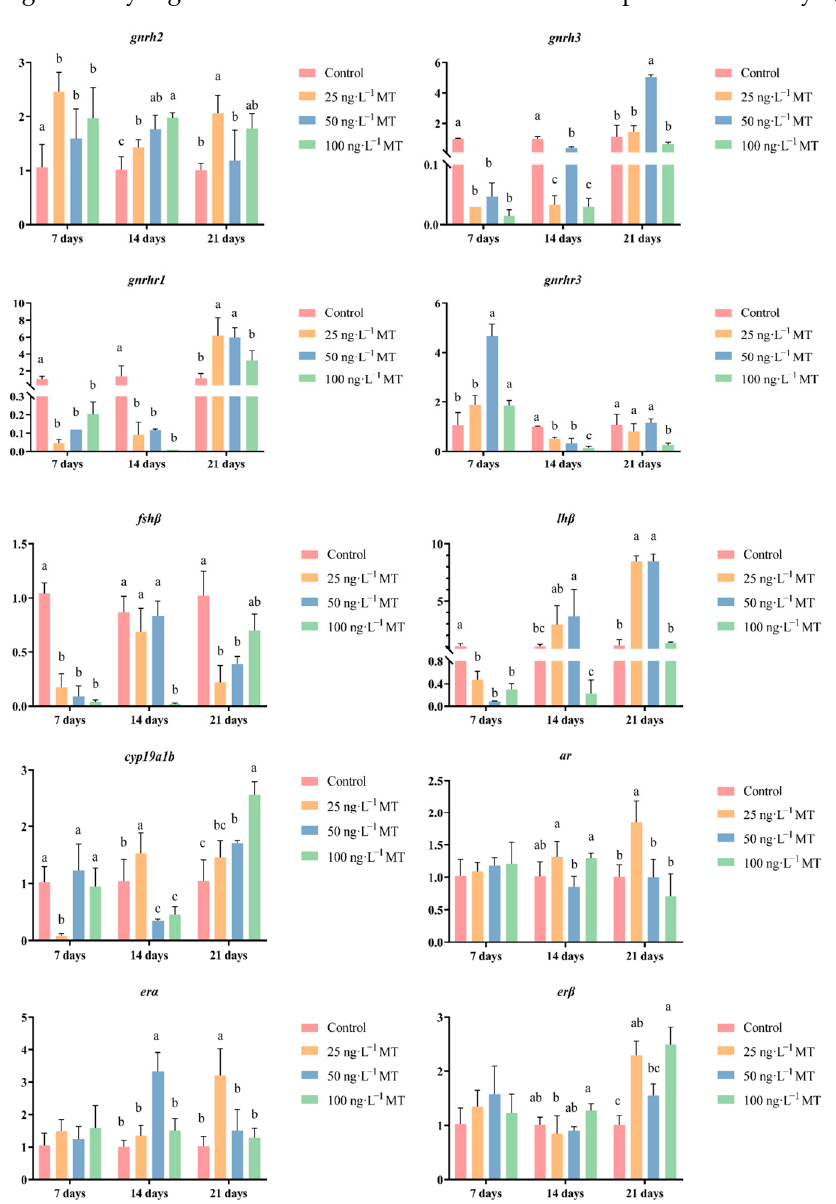
Figure 3. Effect of MT on gnrh2 , gnrh3 , gnrhr1 , gnrhr3 , fsh β , lh β , cyp19a1b , ar , er α , and er β genes in the brain of female G. rarus . Data are expressed as mean ± SD. Statistically significant differences are indicated by different letters ( p < 0.05).